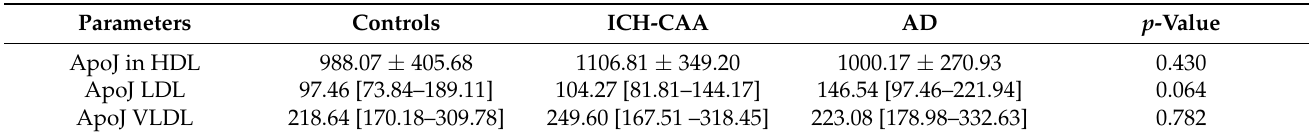
Table 6. ApoJ content in lipoproteins.